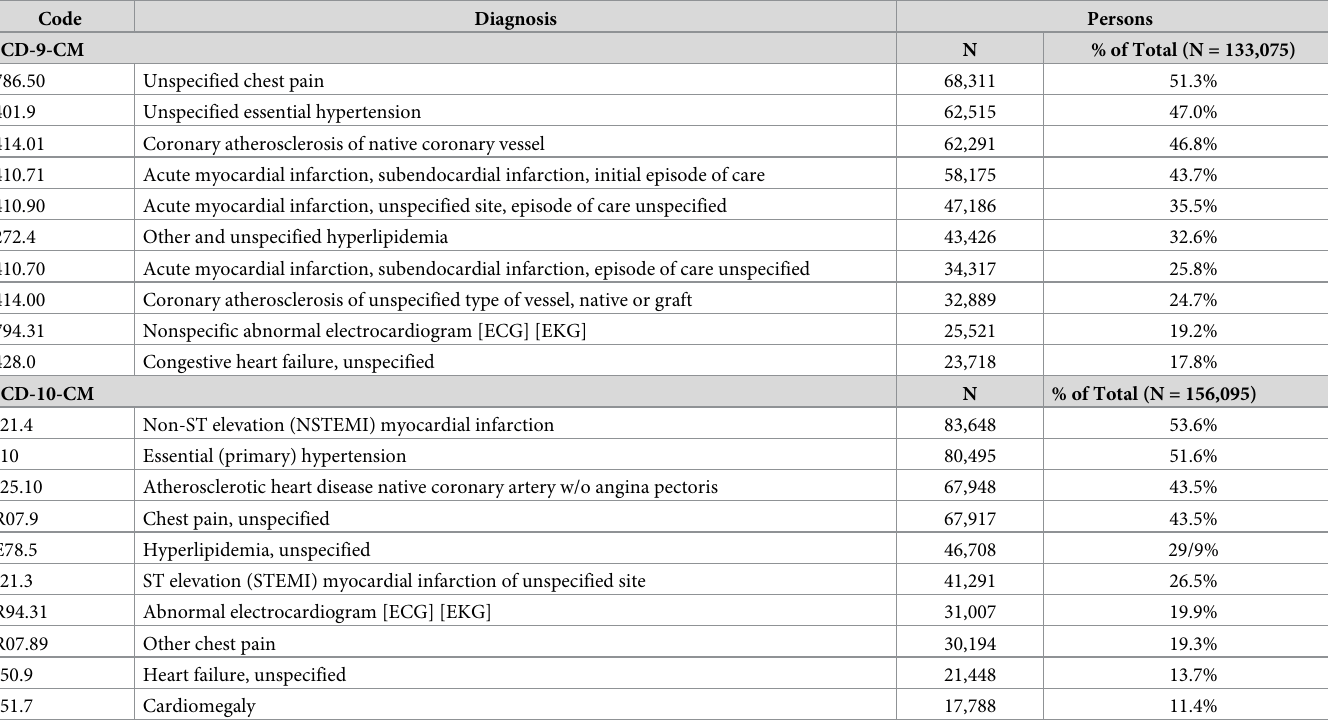
Table 4. Cardiac diagnosis codes most commonly reported the day before or following first AMI diagnosis in any healthcare setting, 2014–2017 �